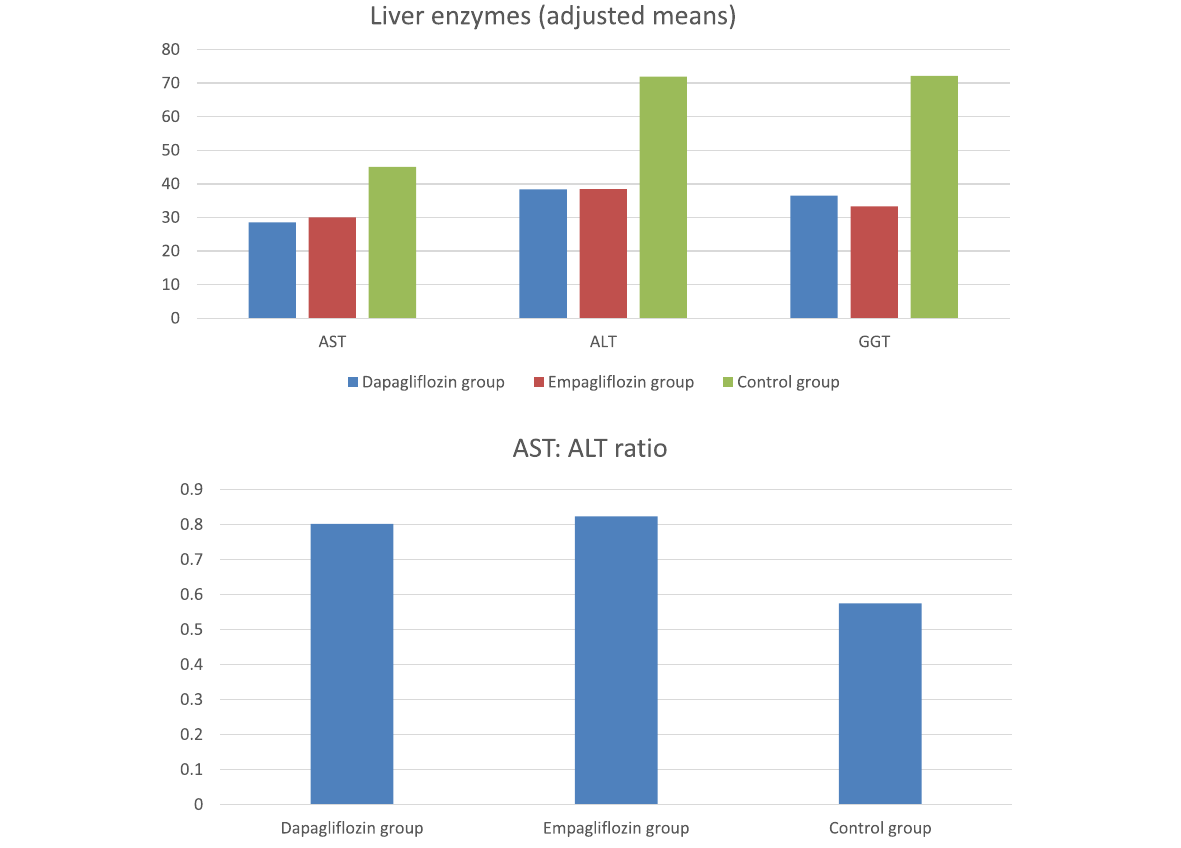
Fig. 3 Hepatic aminotransferases changes after 6 months with adjusted